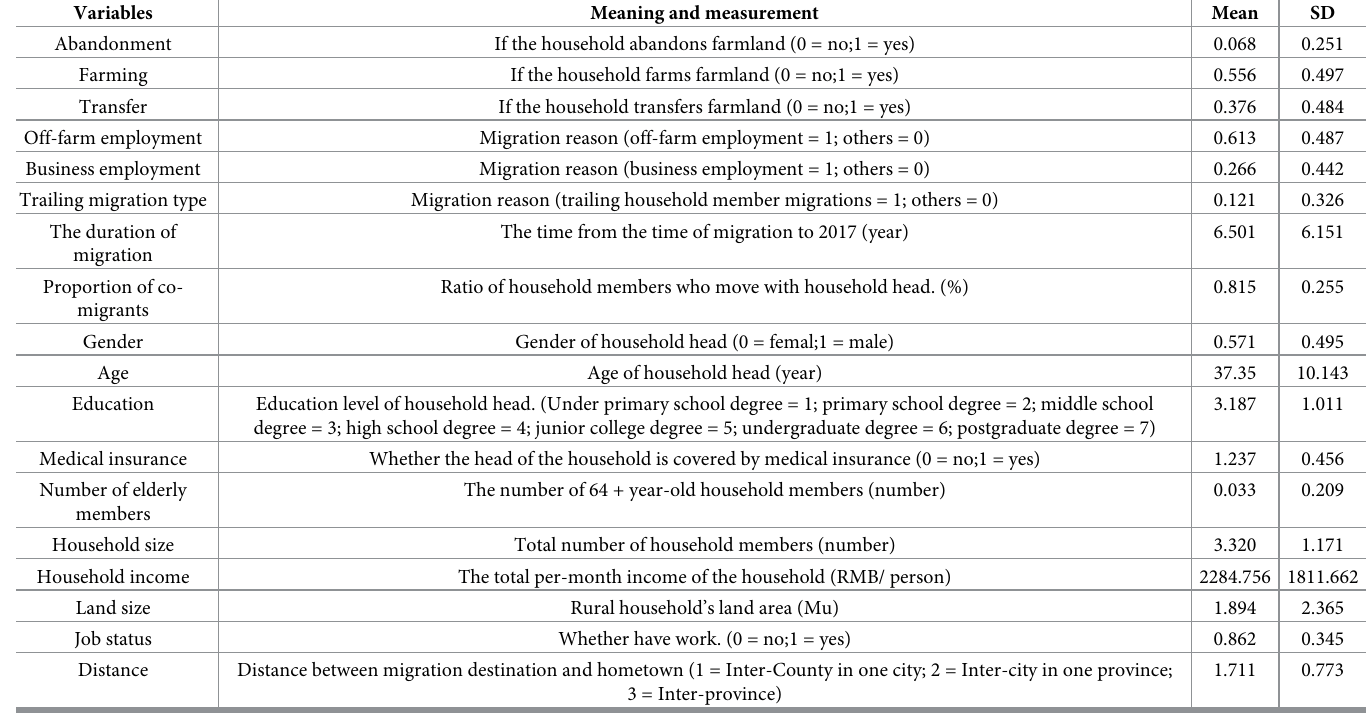
Table 3. Summary